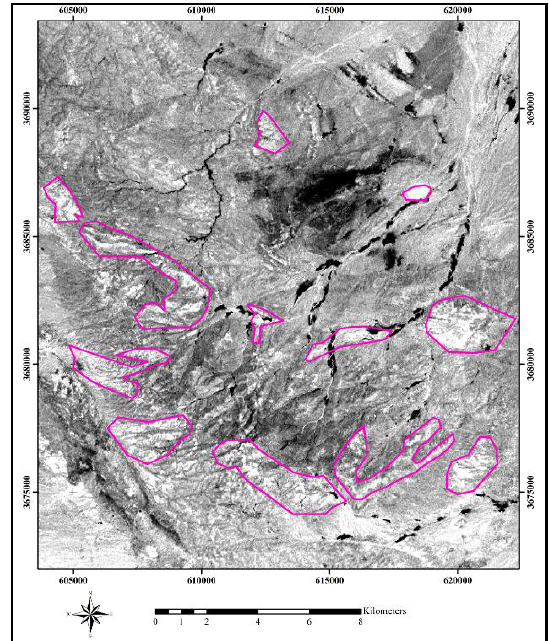
Figure 8. PC3 image for Ardestan scene; ellipsoidal polygons separate bright pixels as probable locations of epidote, calcite, and chlorite minerals.